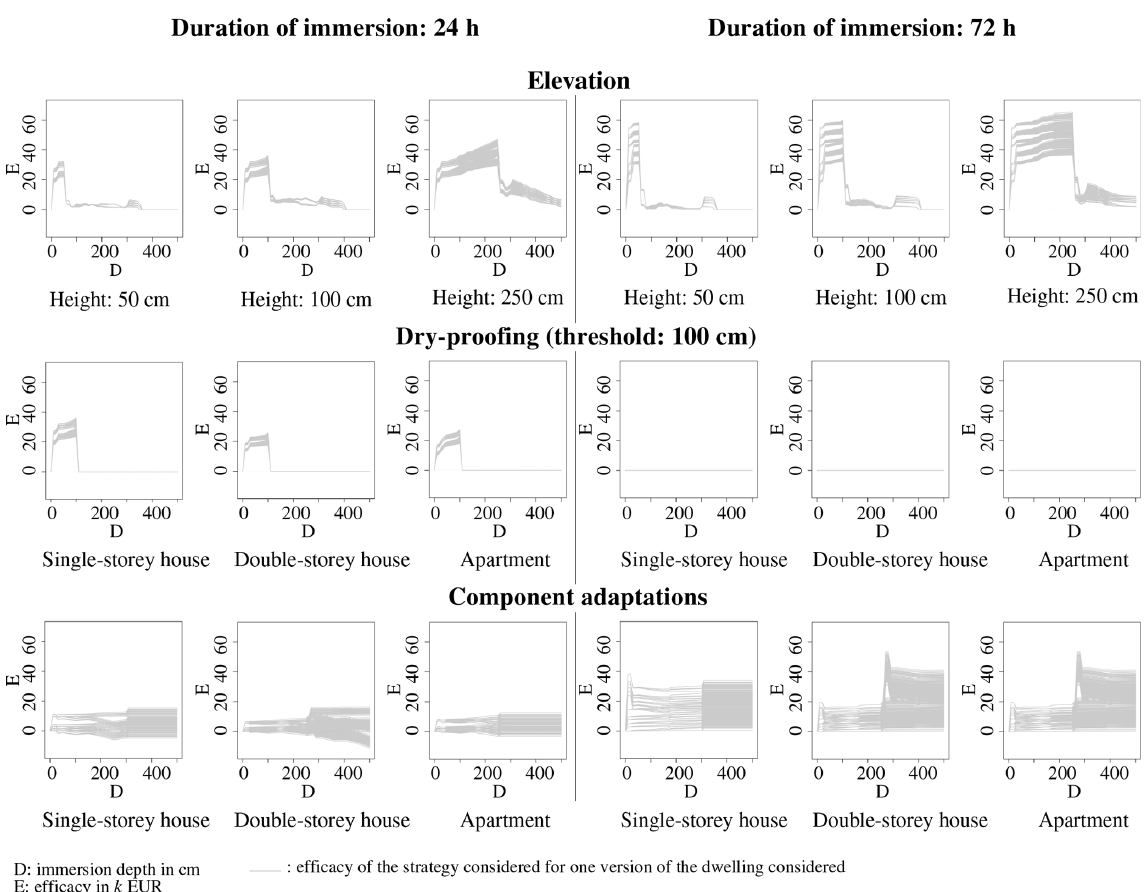
Figure 3. Efficacy of the three strategies for a duration of immersion of 24 or